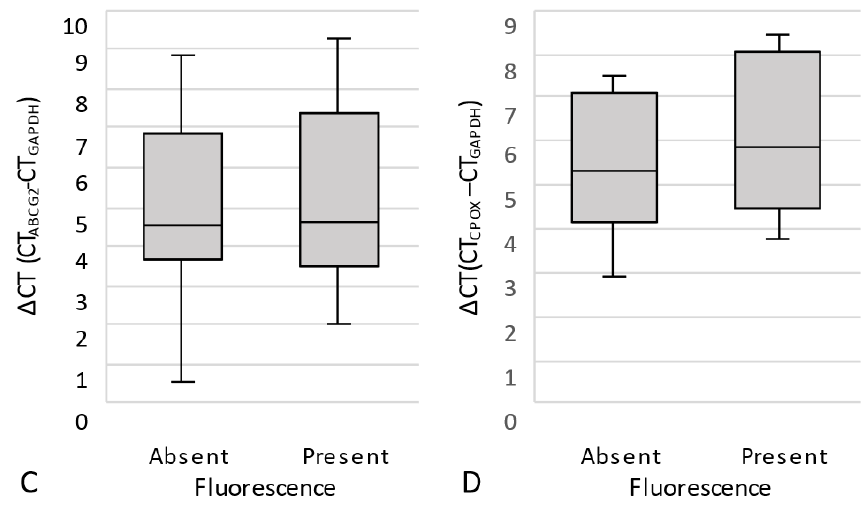
Figure 6. Box-and-whisker plots illustrating ABCB6, ABCG2, FECH and CPOX mRNA expression correlated with fluorescence, determined using qPCR. No correlation of the relative expression of ABCB6 (( A ), p = 0.972), ABCG2 (( B ), p = 0.896), FECH (( C ), p = 0.744) and CPOX (( D ), p = 0.393) with tumor fluorescence at the mRNA level was found. The boxes indicate upper and lower 25% quartiles, the whiskers indicate the minimum and maximum value, the dots indicate the outliers, and the heavy horizontal line indicates the median.